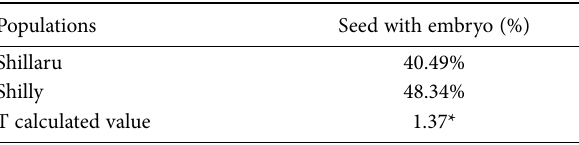
Table 8. Overall percentage of seeds (with embryo) comparison between two population of A. glauca.